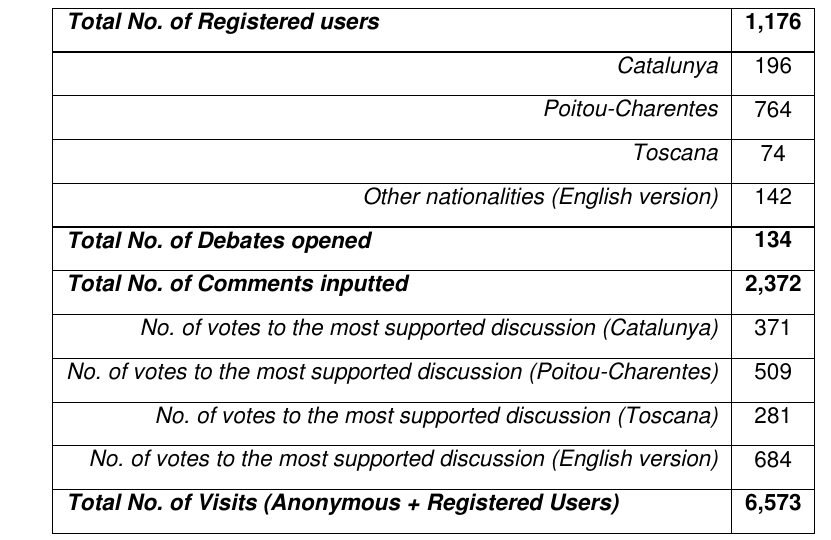
Table 1: SNP Indicators (July-December